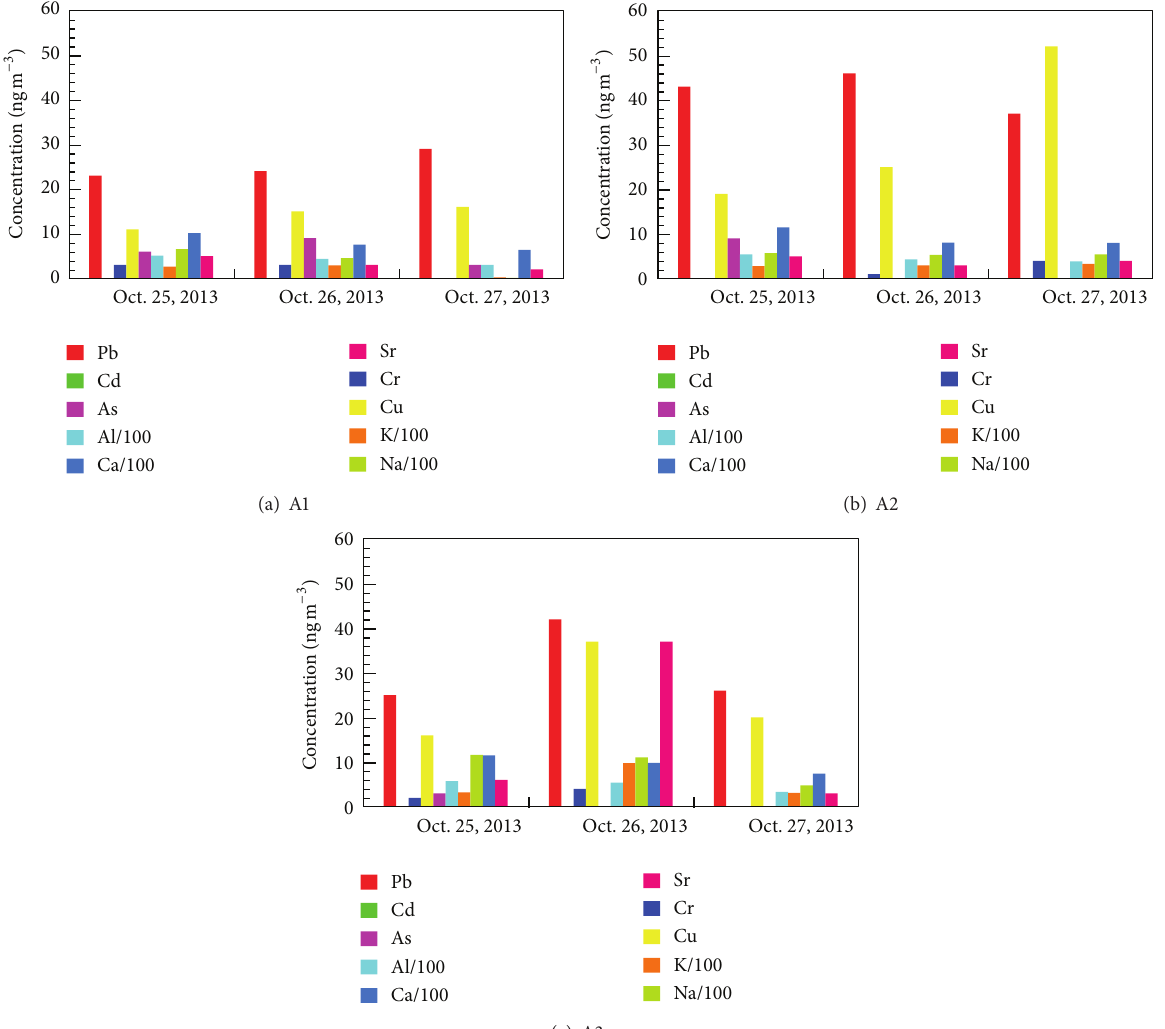
of the 2012 event (5.7 ng m −3 ). The ratios of As to Cr (0.8–1.1) after the burning of fireworks (Oct. 26-27) were significantly lower than that (3.5) during the pre-BFF day (Oct. 25). An annual mean ratio (0.3) of As (2.4 ng m −3 ) to Cr (9.1 ng m −3